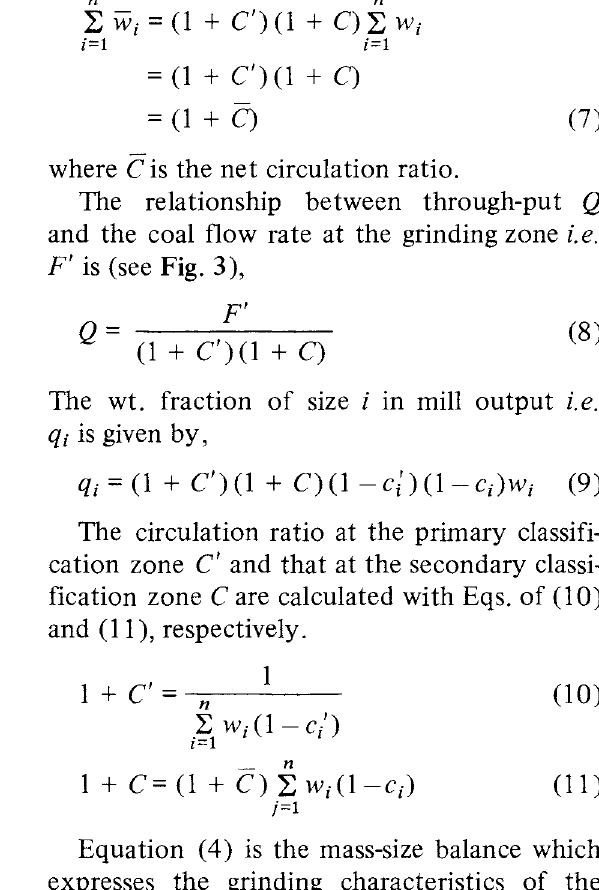
Fig. 3 Nomenclature for the complete circuit with primary and secondary